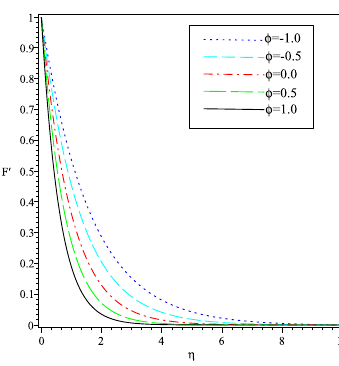
Fig. 15: Comparison between direct (line) and indirect RBFs (points) for β = 0.4, 1 , ϕ = 0 and ε = 0.1